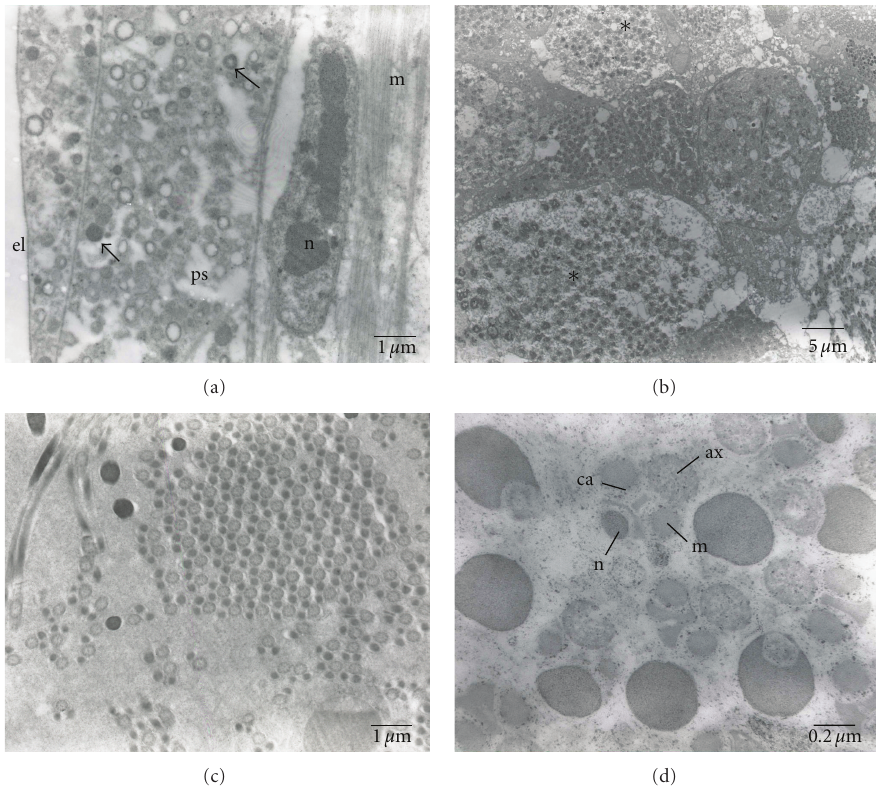
Figure 5: TEM micrographs of the testis of a 7-day-old C. megacephala. (a) Testicular wall displayed an external layer (el), a peritoneal sheath (ps), a muscular layer (m) with nucleus (n). Rounded grains containing pigment, with varying density levels, are spread in the cytoplasm (arrows). (b) Development of sperimatozoa inside the germ cells (asterisks). (c) Enlargement of (b) presenting group of spermatozoa. (d) Spermatozoa showing nucleus (n), centriolar adjunct (ca), axoneme (ax), and mitochondrial derivatives